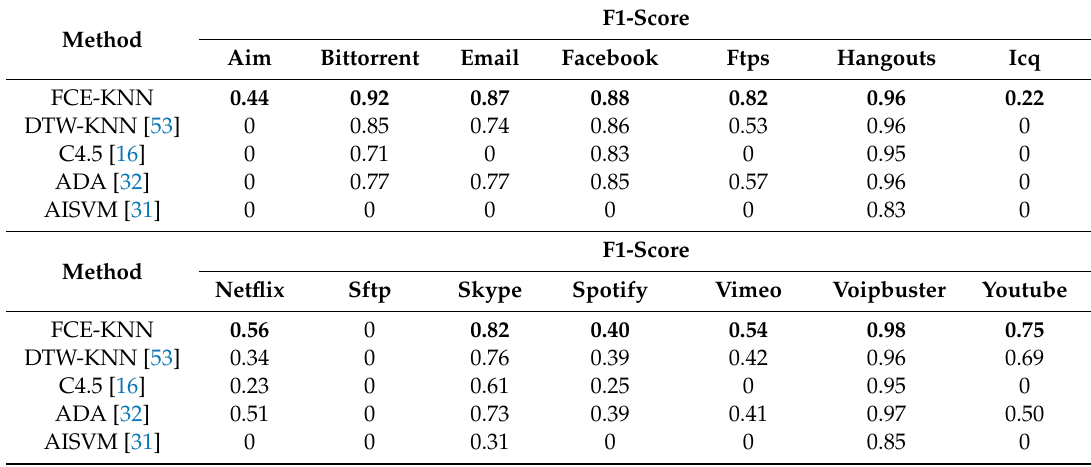
Table 7. F1-score comparison of FCE-KNN for identifying application type of encrypted network flows with other